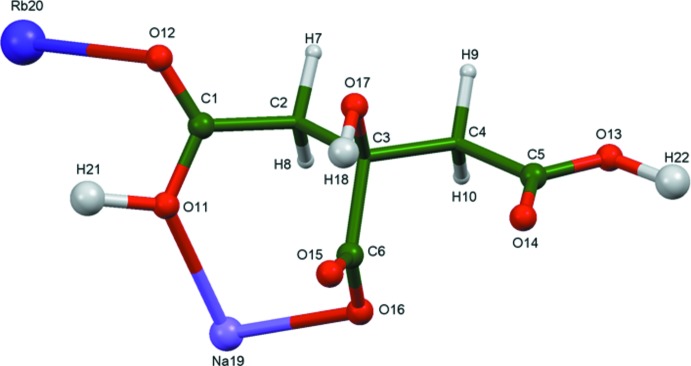
The asymmetric unit of NaRbHC6H5O7, with the atom numbering and 50% probability spheroids.